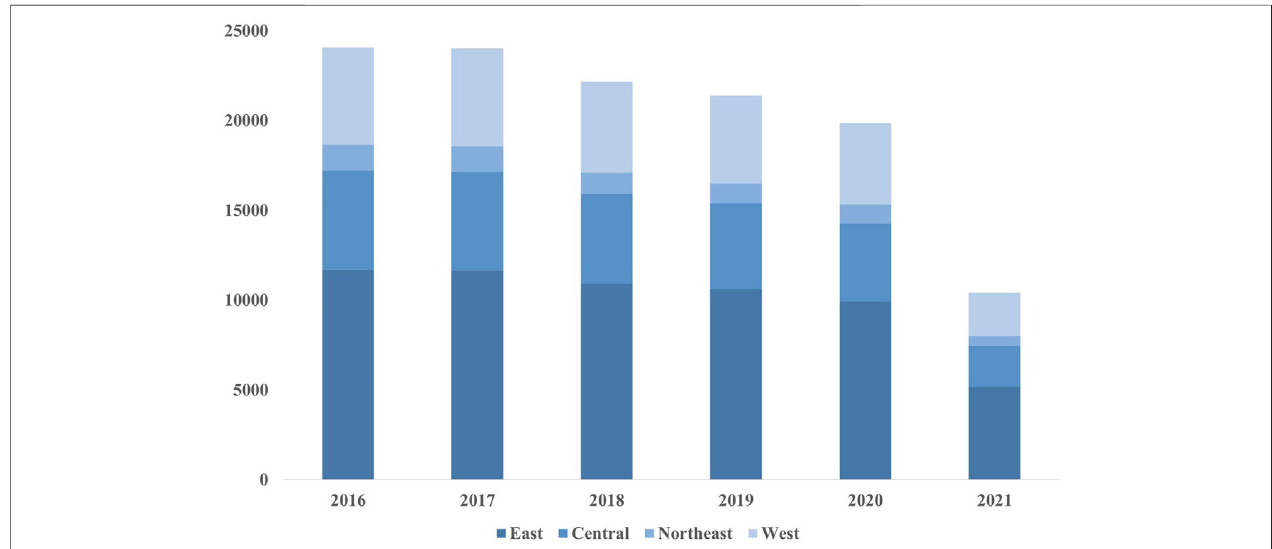
FIGURE 2 | Sales of new energy vehicles in China ’ s four major economic regions from 2016 to the fi rst half of